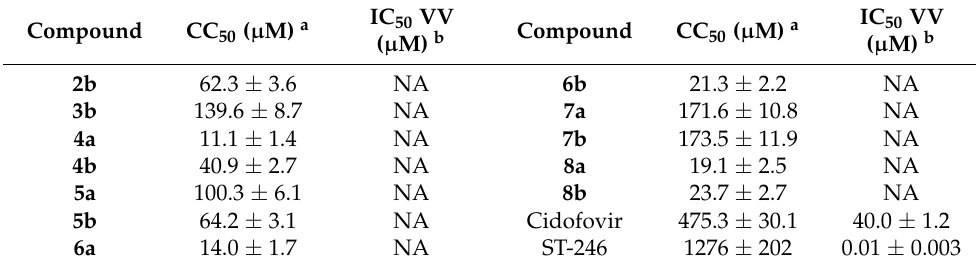
Table 4. Antiviral activity of derivatives 2–8 a–b against vaccinia